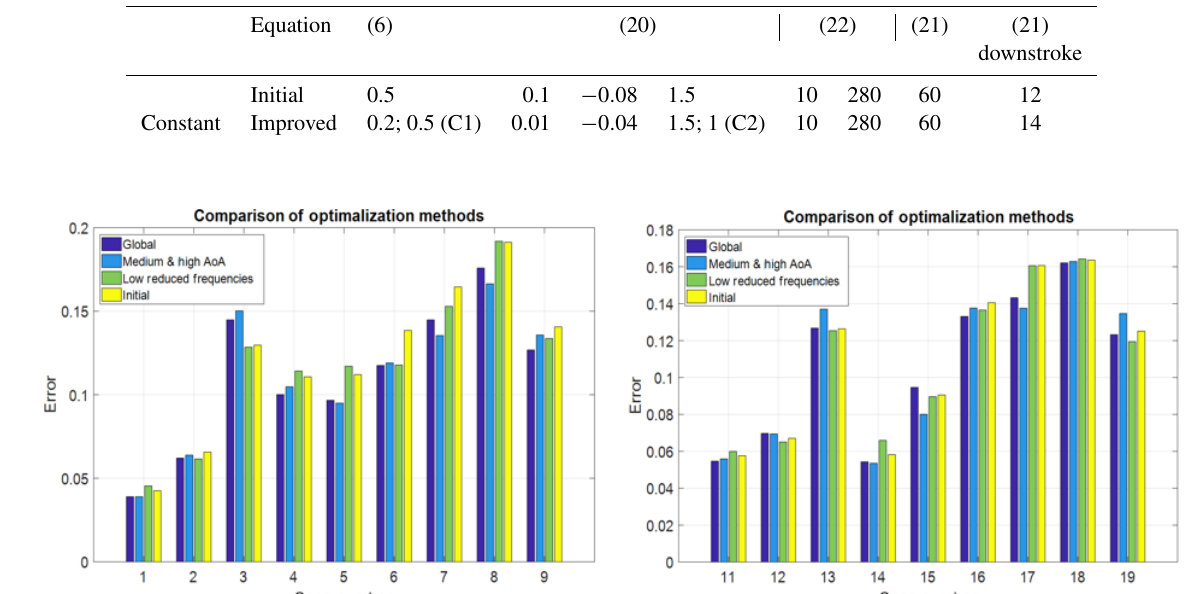
Figure 6. Absolute error analysis of the optimization runs for all cases from Table 1.